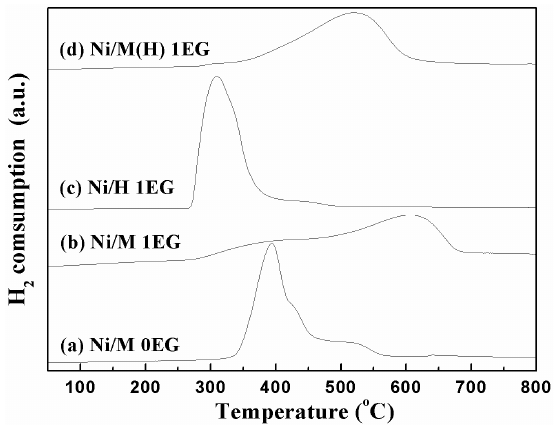
Figure 3. H 2 temperature ‐ programmed reduction (H 2 ‐ TPR) of different samples with 20 wt % Ni loading.